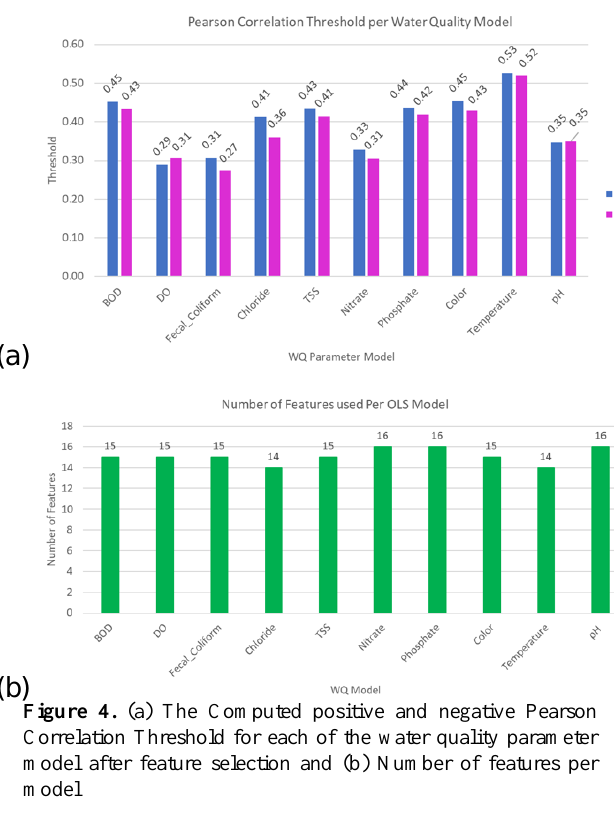
(b) Figure 4. (a) The Computed positive and negative Pearson Correlation Threshold for each of the water quality parameter model after feature selection and (b) Number of features per model